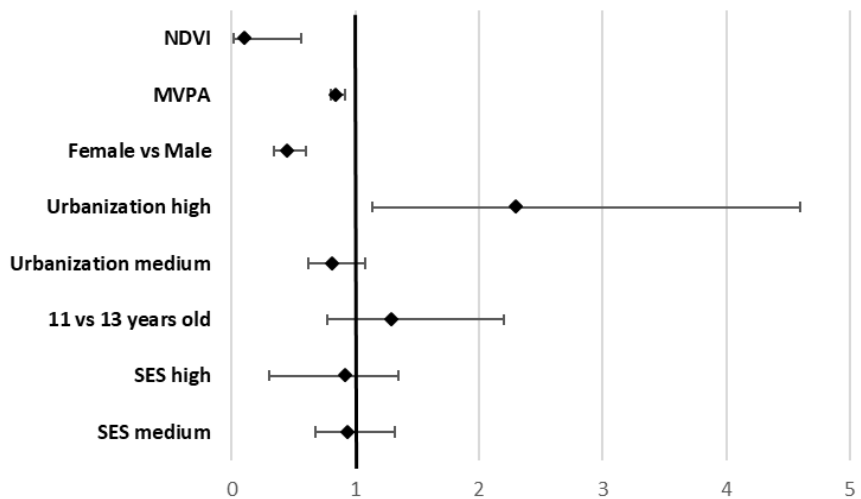
Figure 2. Multilevel regression model (OR and 95% CI) of OwO according to NDVI, urbanization levels, and physical activity, adjusted for gender, age group, and socioeconomic status. Abbreviations: OwO = Overweight and Obese; SES = Socioeconomic status; MVPA = Moderate-To-Vigorous Physical Activity; NDVI = Normalized Difference Vegetation Index.